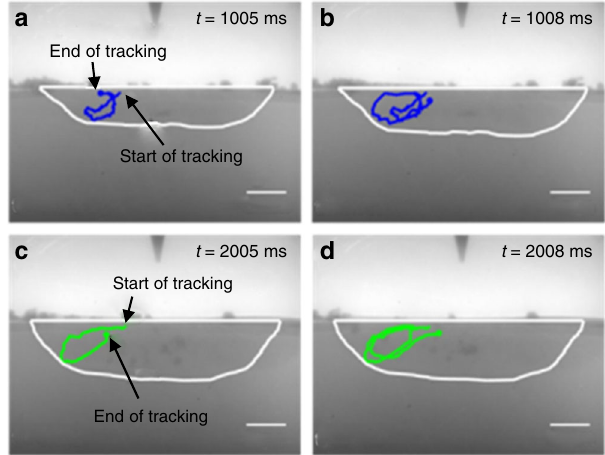
Fig. 3 Fluid fl ow observed in low S steel melt pool. Tracer particles are tracked using a 1ms temporal resolution — the maximum temporal resolution available. a Tracks a tracer particles movement from 1.00s to 1.005s. The loci joining each tracer position show the path of the particle and indicates an anti-